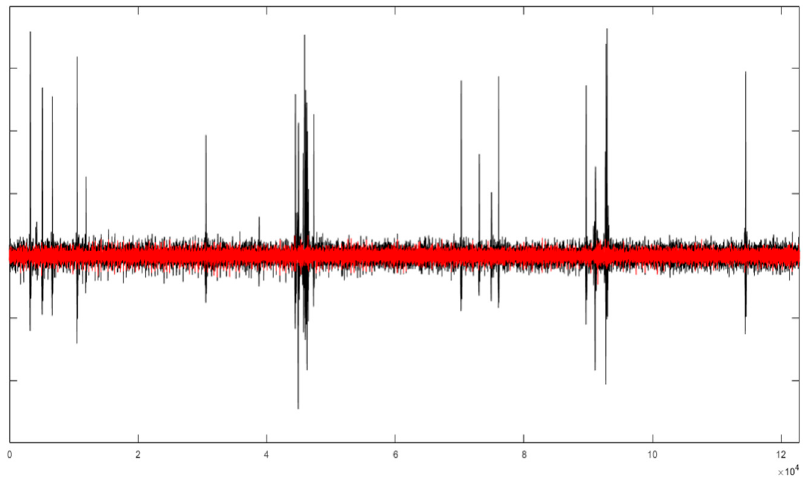
Figure 13. The AF8 channel of AEEG with (in black) and without artefacts (in red) after using SASICA. The X axis shows the samples.